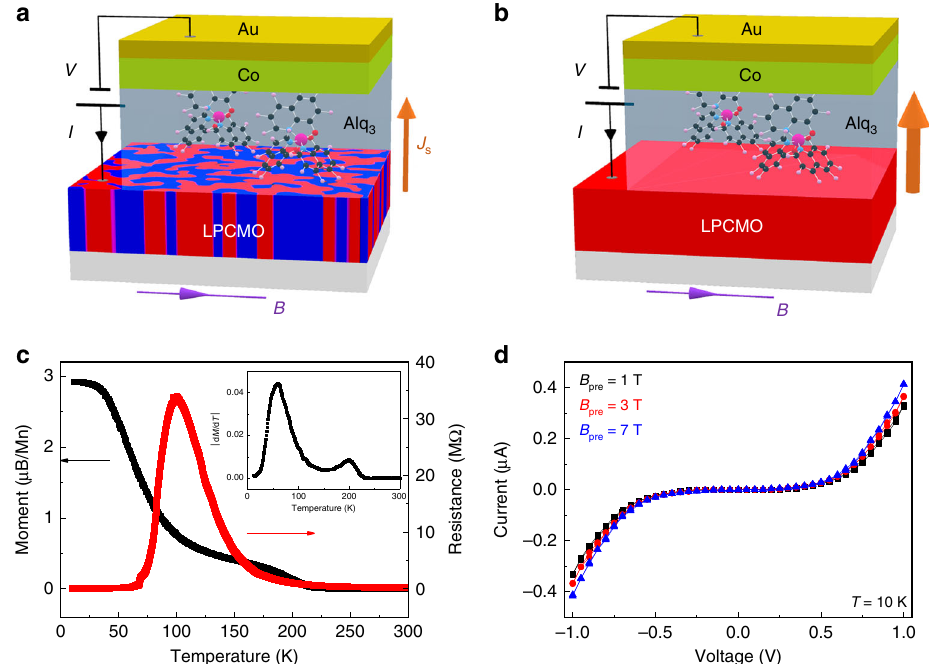
Fig. 1 Schematic structure and transport properties of the OSVs using complex manganites electrode. a , b The illustration of EPS-modulated spin current injection in the LPCMO-OSVs under the co-existed FM/COI phase ( a ) and fully FM phase ( b ) of the LPCMO thin fi lm, respectively. c The temperature dependence of magnetization ( M vs. T ) and resistance ( R vs. T ) of the LPCMO thin fi lm. The inset shows the temperature dependence of j dM = dT j . d I – V characteristics of the LPCMO-OSV device at 10 K as a function of pre-set magnetic fi eld (i.e., 1 T, 3 T, and 7 T)